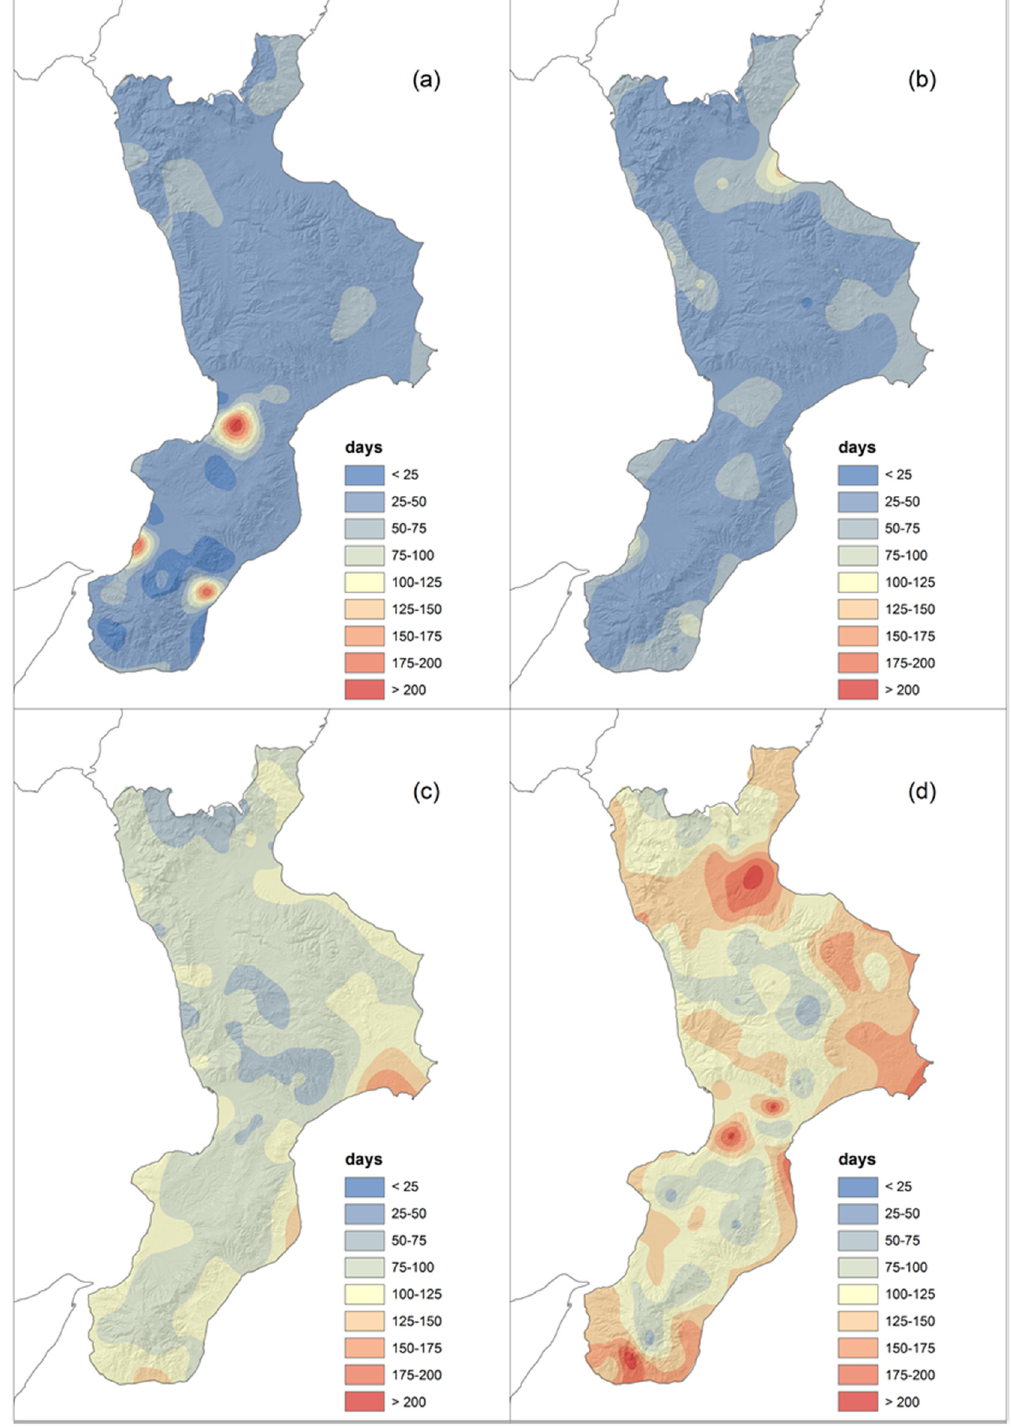
Figure 5. Maximum length of the dry spells on a seasonal basis: ( a ) winter; ( b ) spring; ( c ) summer and ( d )